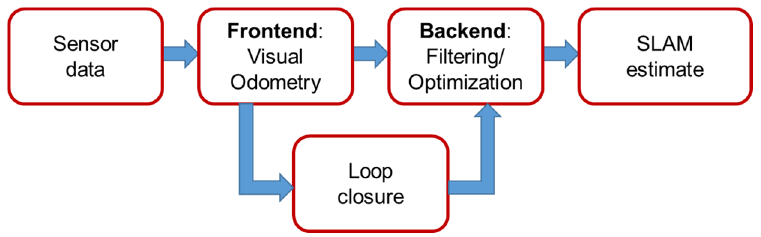
Figure 3. V-SLAM framework.